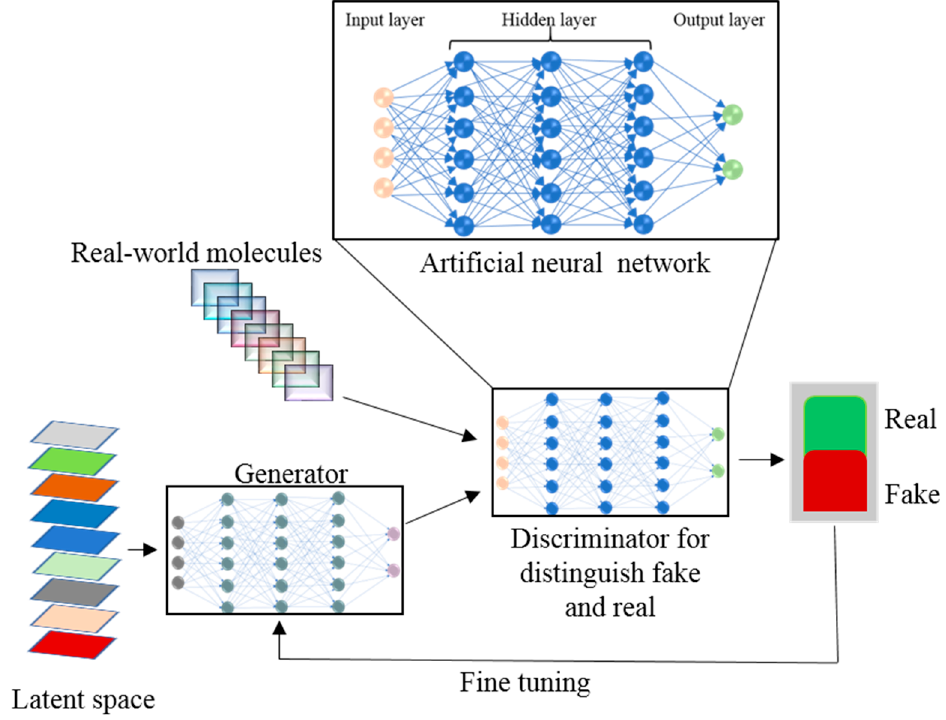
Figure 3. A workflow of the generative adversarial network approach with an artificial neural networks (ANN) for new molecule design.